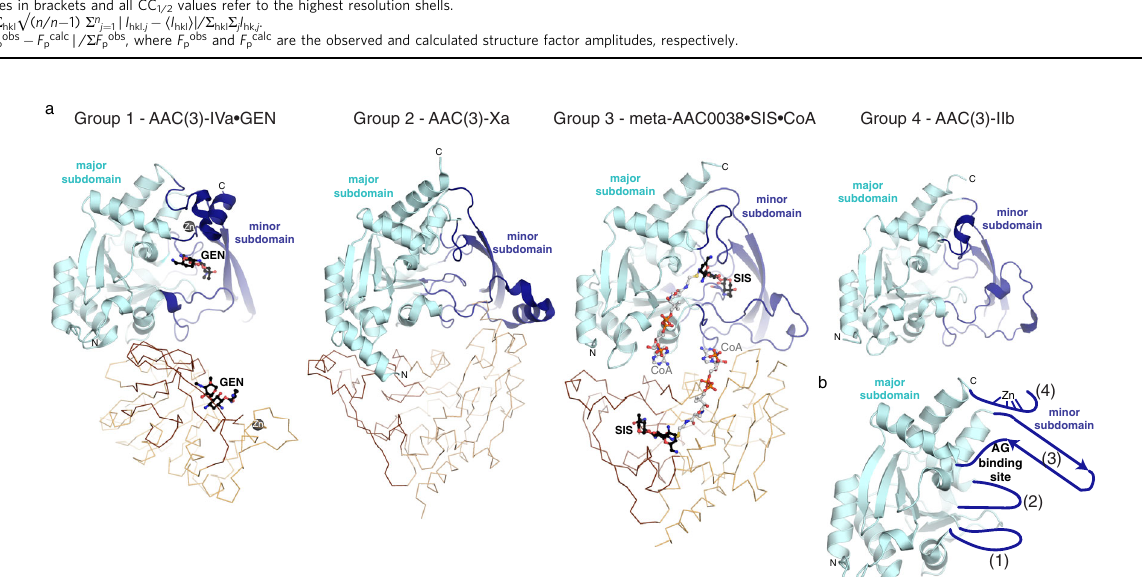
Fig. 3 Structural analysis of Antibiotic_NAT enzymes. a Structures of AAC(3)-IVa, AAC(3)-Xa, meta-AAC0038, and AAC(3)-IIb as representatives of groups 1 – 4, respectively. The conserved major subdomain of the Antibiotic_NAT fold is colored in cyan; the variable minor subdomain is colored in dark blue. The second subunit in the AAC(3)-IVa, AAC(3)-Xa and meta-AAC0038 crystal structures are shown in thin orange lines. Zn 2 + ion bound to AAC(3)-IVa is shown as a dark gray sphere. Ligands bound to AAC(3)-IVa and meta-AAC0038 are shown in sticks and labeled. b Schematic of structural variations in the minor subdomain as insertions or extensions to the major subdomain, numbered 1 –